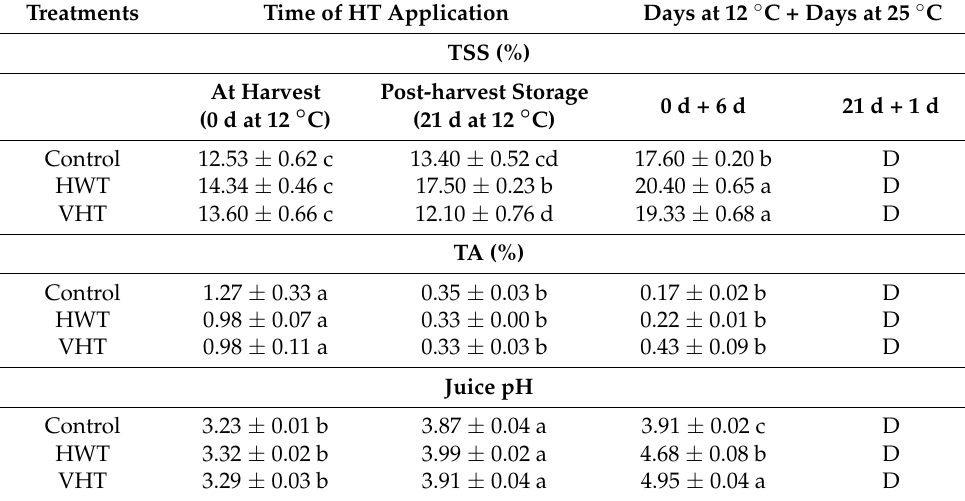
Table 1. Effect of the heat treatments applied at harvest and post-harvest storage on total soluble solids (TSS), titratable acidity (TA) and juice pH of mango fruits. Data are presented as mean ± SE ( n = 3). Different letters indicate significant differences according to LSD at p ≤ 0.05.